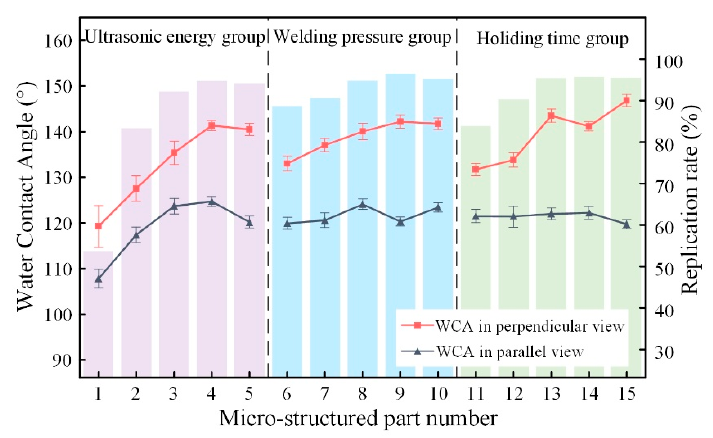
Figure 10. The water contact angles (WCA) and replication rate of micro-structured parts.